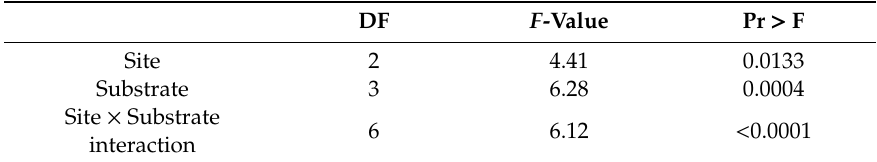
Table 2. Repeated measures ANOVA for the proportion of sowed seeds that emerged as seedling and survived the entire growing season at three sites in Coyhaique (nine measurements for each experimental sites). DF F -Value Pr > F Site 2 4.41 0.0133 Substrate 3 6.28 0.0004 Site × Substrate 6 6.12 < 0.0001 interaction